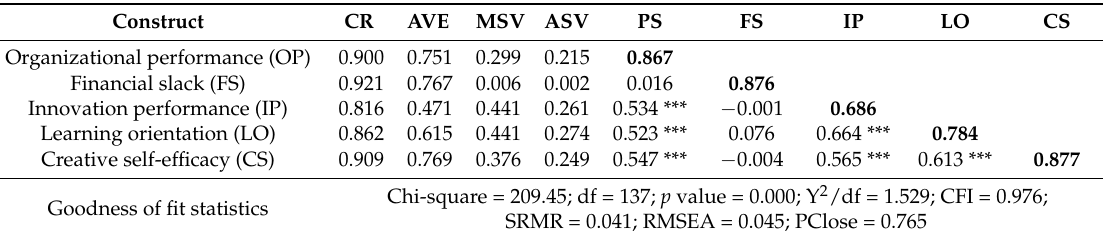
Table 5. The overall reliability of the construct.